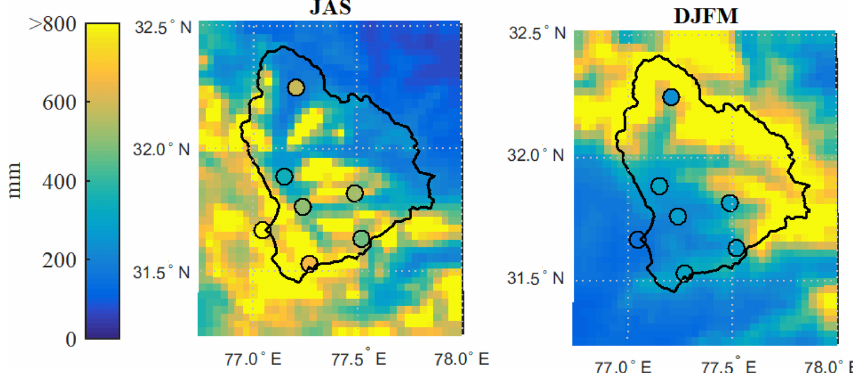
Figure 2. Seasonal precipitation of July–September (JAS) and December–March (DJFM) during 1998–2005 from 3km WRF (from Li et al., 2017) and Gauge (dot) in the upper Beas